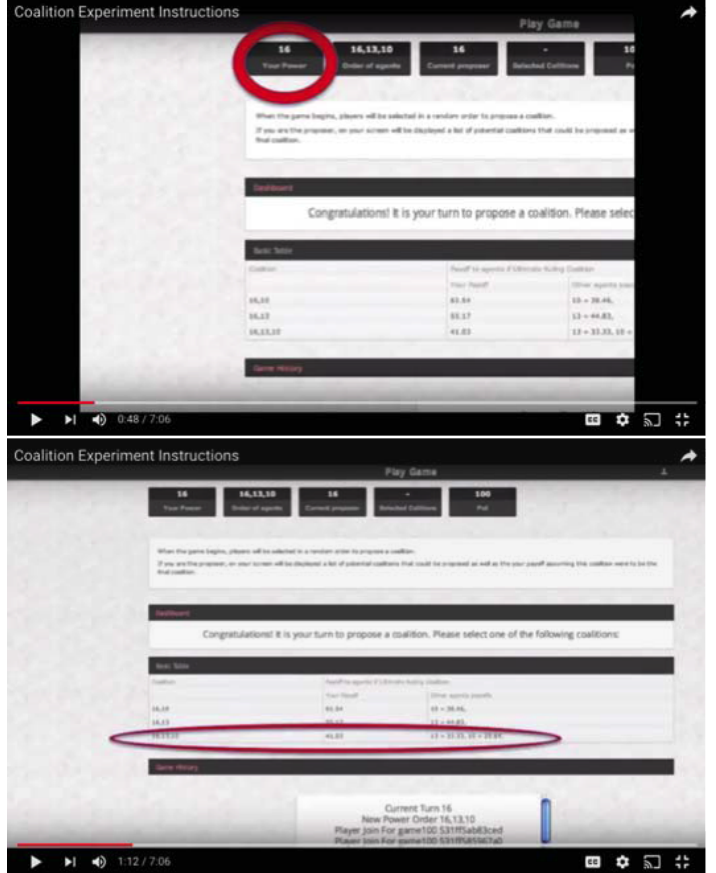
Figure A2. Screenshot of the instructions video:proposal